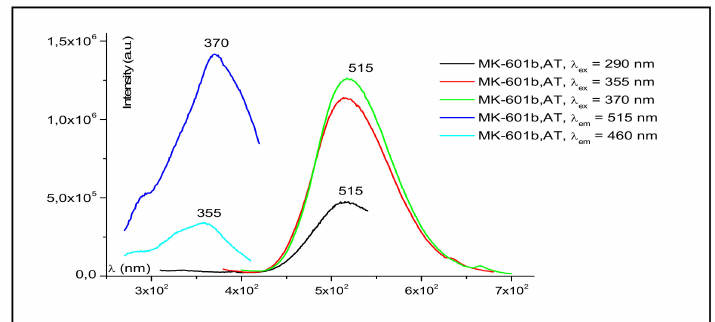
Figure 9. Luminescence spectrum of PS-4-co-PVP · AuC 6 F 5 at several excitation wavelengths. The pyrolysis of all these macromolecular precursors affords metallic Au ◦ foams with pore size depending on the nature of the Au salt joined to the polymer chain [94] (Figure 10).